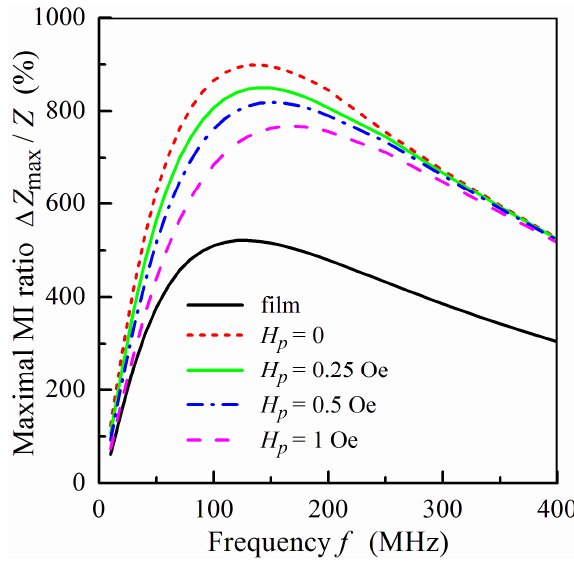
Figure 9. Frequency dependence of the maximum value of the MI ratio Δ Z max / Z for ferrogel at different values of the effective stray field H p . Other parameters used for calculations are the same as in Figure 8.